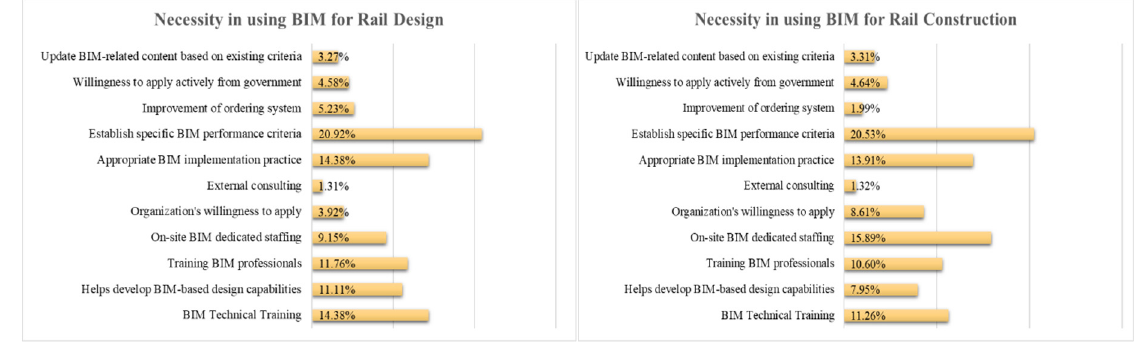
Figure 6. Preferences on BIM for Rail Industry.